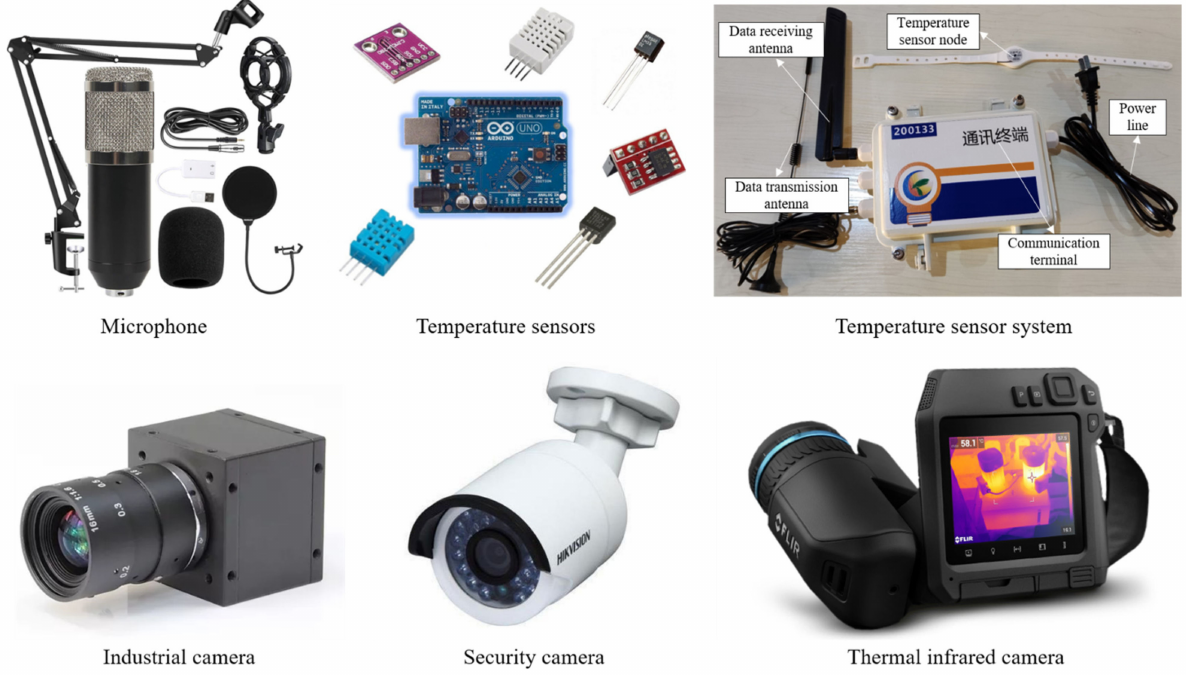
Figure 2. Some commonly used state-of-the-art devices, including microphones, sensors and cameras, can be used to obtain physiological and behavioral information of poultry to detect clinical warnings of poultry